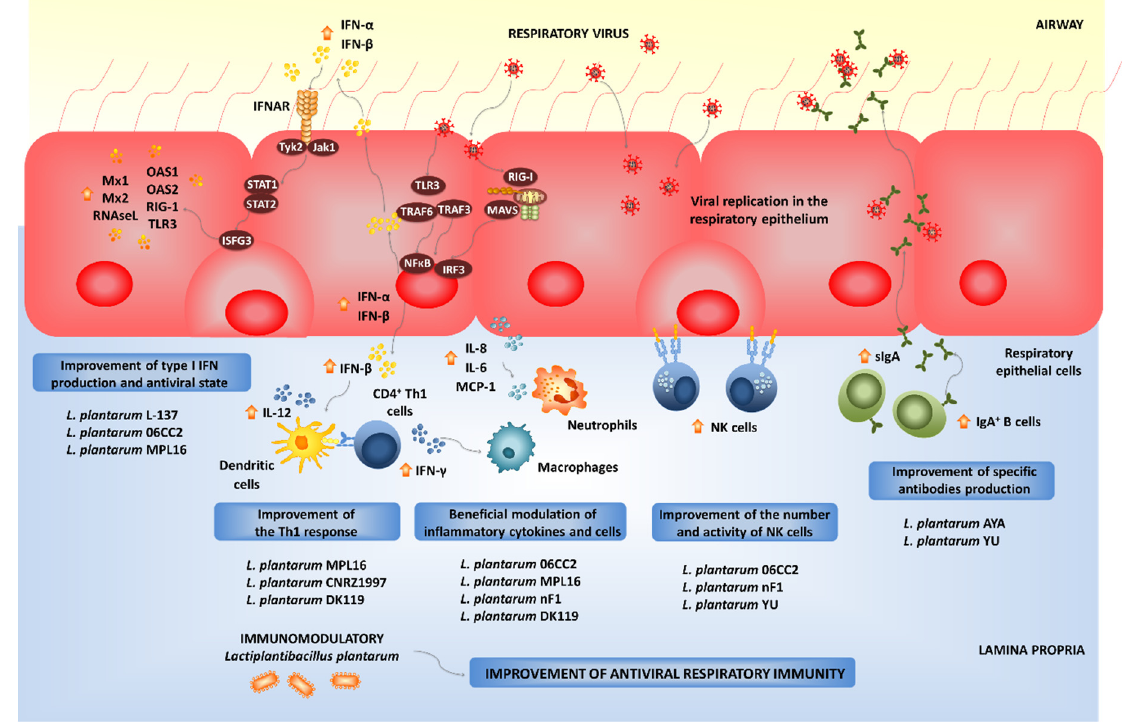
Figure 4. Beneficial effects of orally administered immunobiotic Lactiplantibacillus plantarum strains on the resistance and immune responses against viruses in the respiratory mucosa.